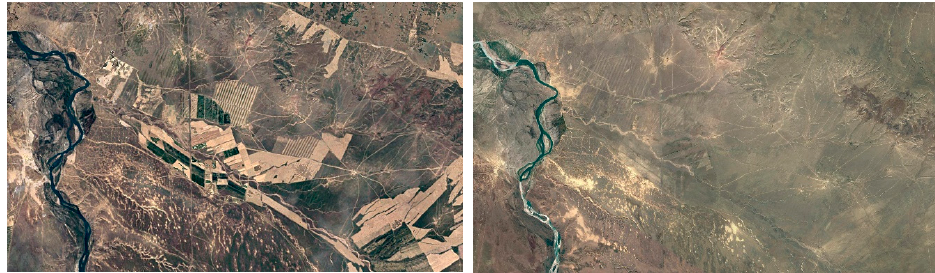
Figure 7. Landsat satellite images of the active Kerbulak irrigation site in 1990 ( Left image) and the abandoned site in 2018 ( Right image).